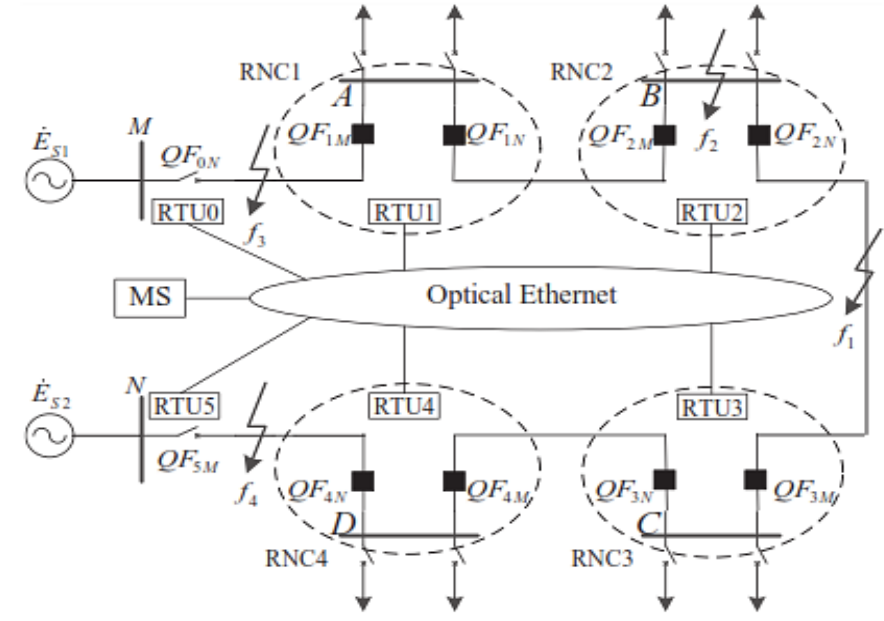
Figure 9. Common configuration of a closed loop distribution network with two busbars.